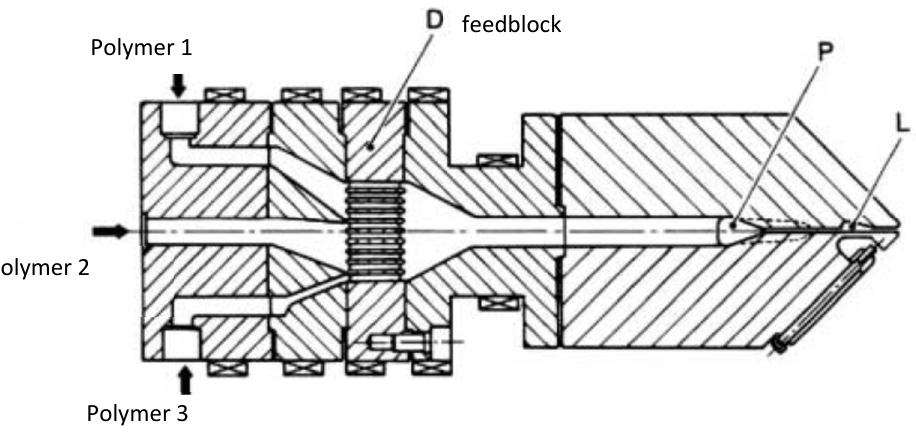
Figure 4. Feedblock die (Reprinted from Ref. [2]).